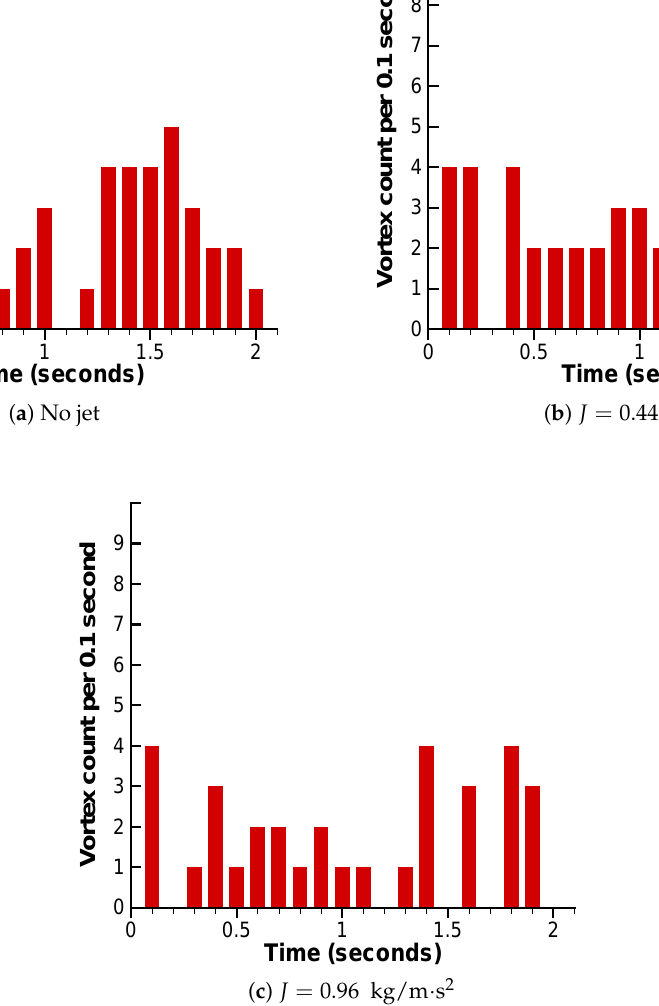
Figure 17. Vortex count of the coherent vortical structures for Re D ≈